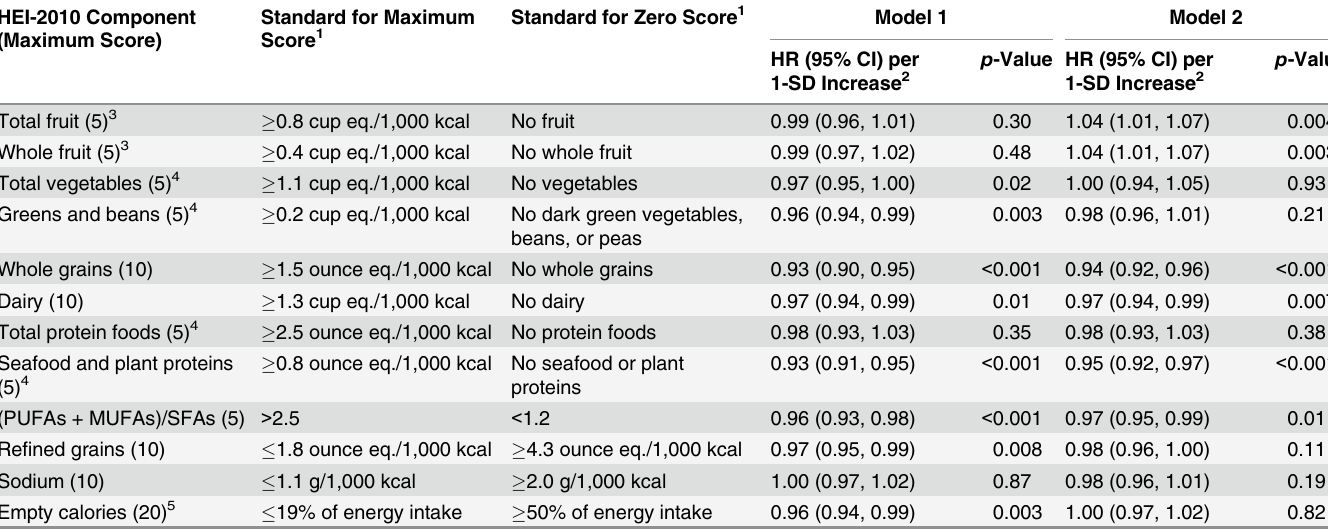
Table 4. Association of HEI-2010 component scores with total disease mortality in the Southern Community Cohort Study, 2002 – 2011. HEI-2010 Component (Maximum